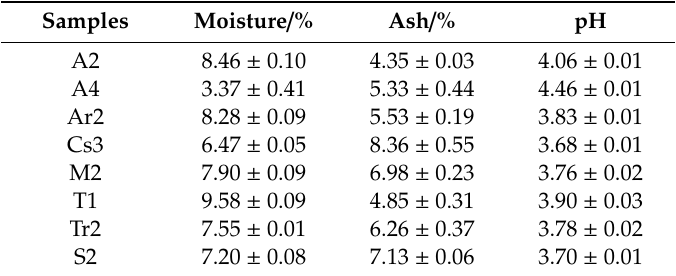
Table 2. Moisture, Ashes, and pH analyses.